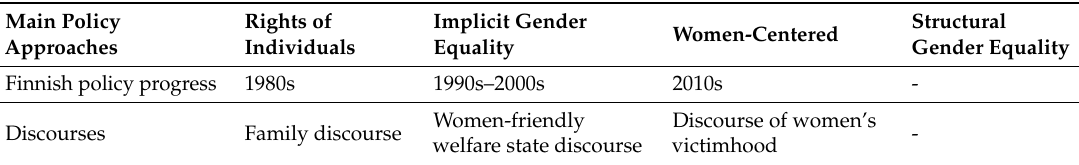
Table 1. Timeline of Finnish policy progress in gender equality